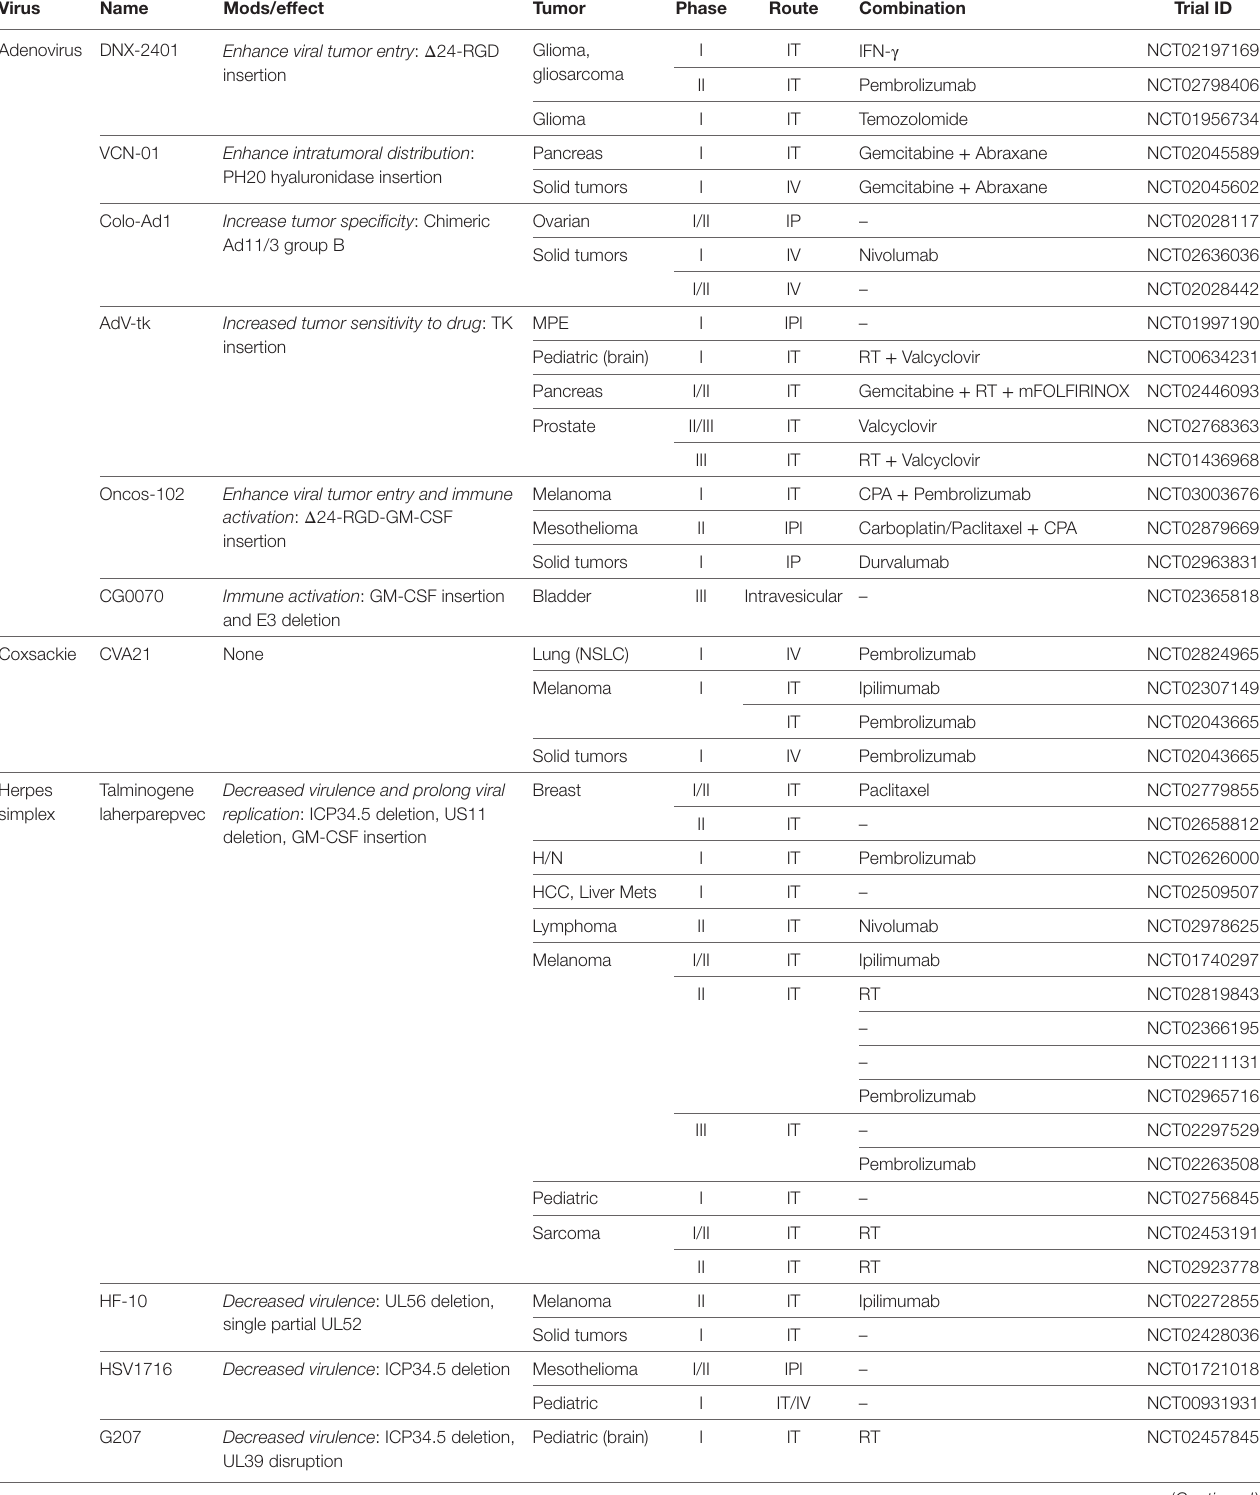
Table 1 | Selected ongoing clinical trials using oncolytic viruses.